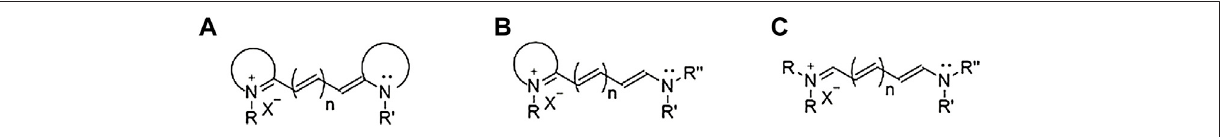
FIGURE 4 | General structures of (A) cyanines, (B) hemicyanines, and (C)